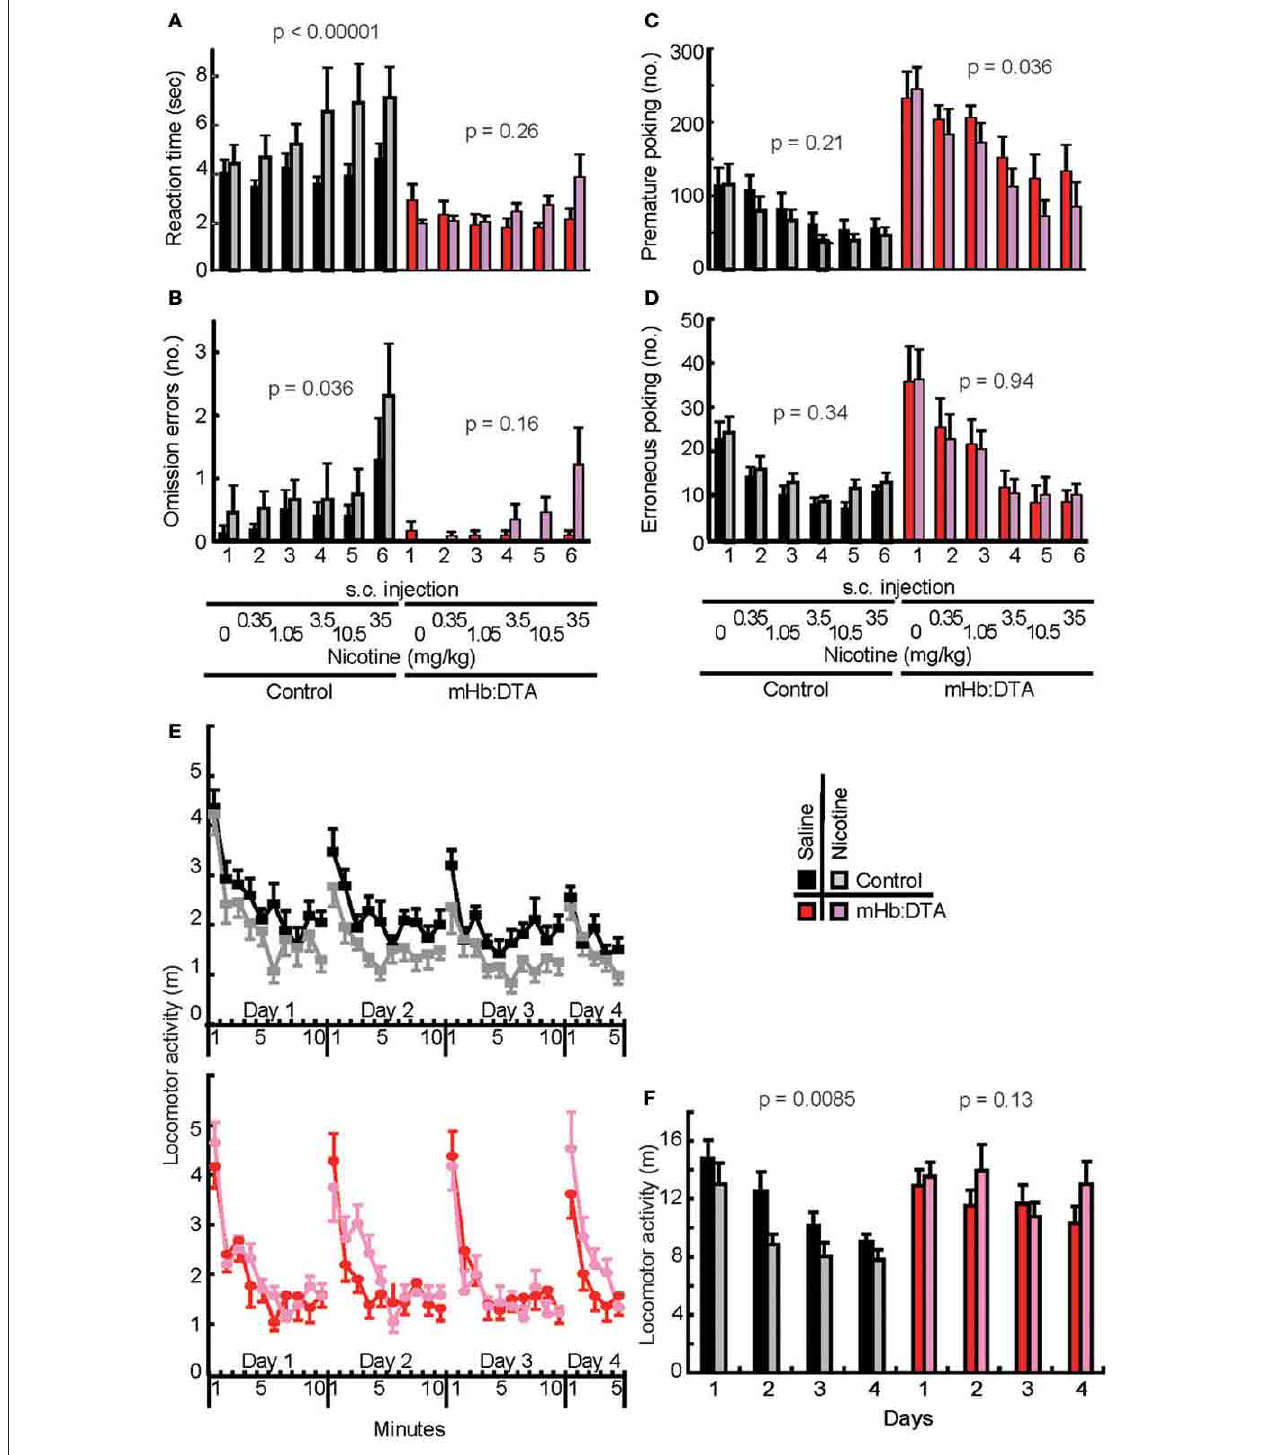
FIGURE 7 | Lack of susceptibility to nicotine in mHb:DTA mice on 5-CSRTT performance and adaptation to a new environment. (A–D) Effects of nicotine on 5-CSRTT performance (mice were 9–11 months old, control-saline n = 9, control-nicotine n = 7, mHb:DTA-saline n = 7, mHb:DTA-nicotine n = 8). (A) Reaction times for nose-pokes after the presentation of signal light in 5-CSRTT. Nicotine (expressed as a free base